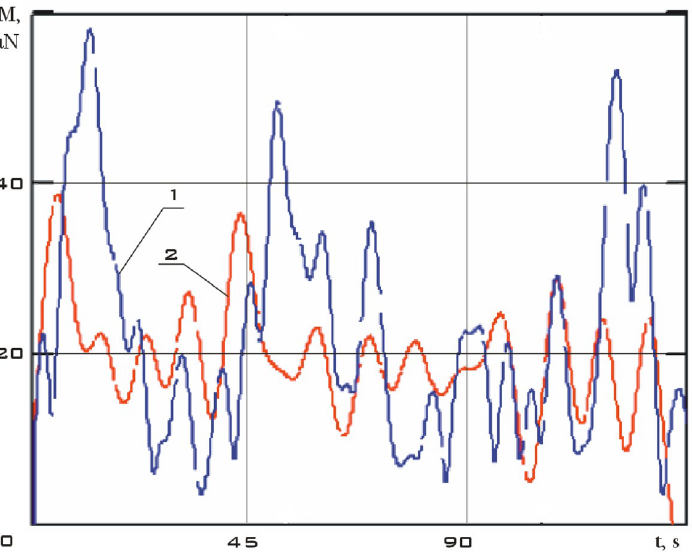
Figure 20. There are modulus of the disturbing moment in the CXYZ coordinate system. 1 is according to model (1) taking into account all disturbances; 2 is according to the formula (7), taking into account the magnetic interaction of the actuators with the Earth’s magnetic